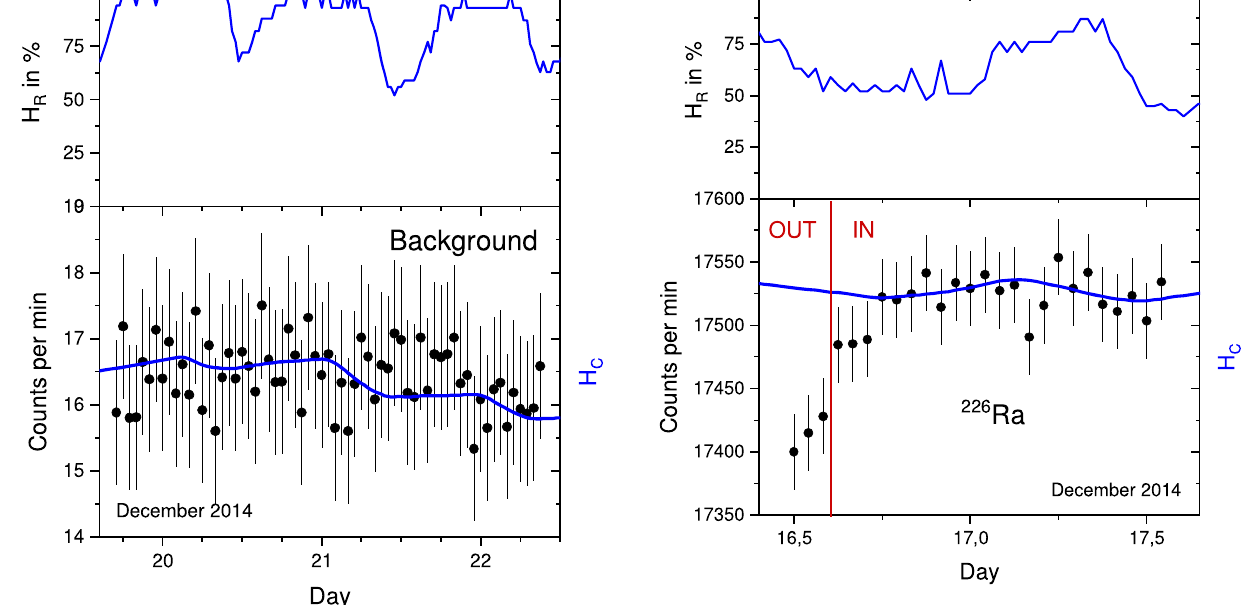
Fig. 6 Relative humidity in the Valencia region (top) in the period 19–22 Dec 2014 [68]. Qualitative comparison (bottom) of mea- sured background rates [27,29] with the accumulated-humidity model H C ( t ; ¯ H R = 92% ,(cid:3) t = − 7h ) in Eq. 1